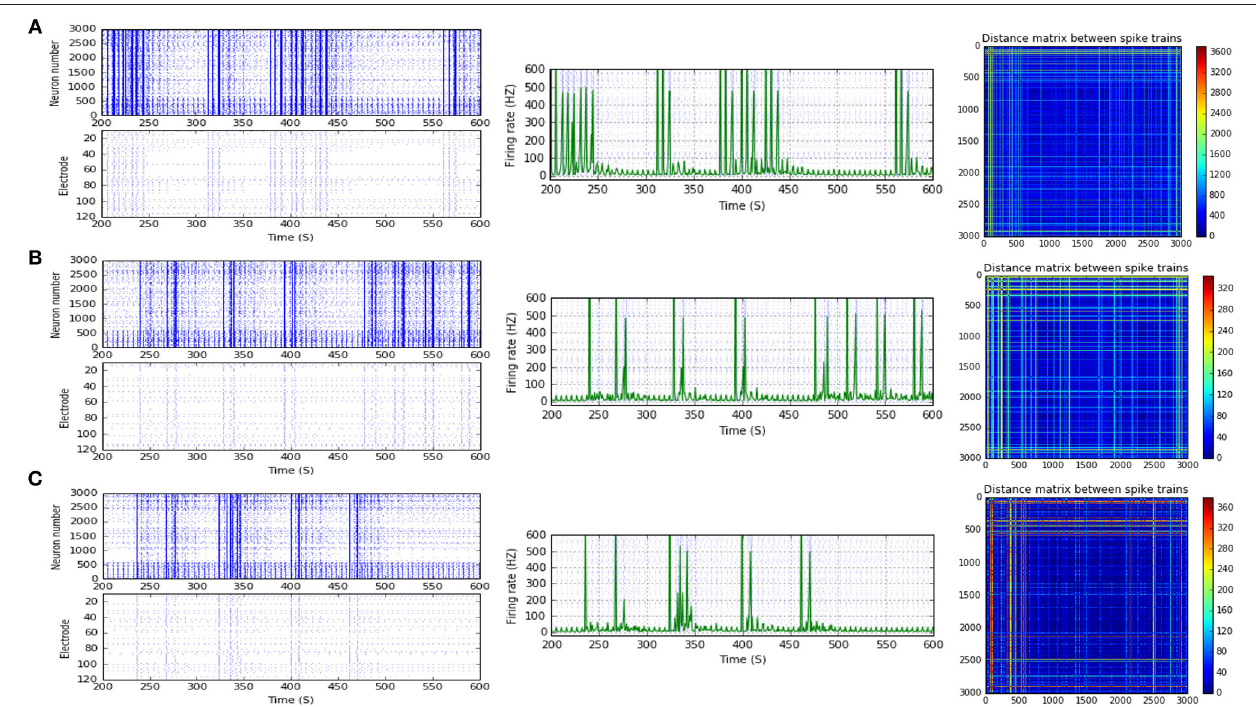
FIGURE 6 | Selected elicited firing response activity in the immature network scenario (B-2) before and after implementing STF1 and STF2 (when IF range of beta). (A) refers to the condition without implementing dynamical synapses (control) while (B,C) refer to that after implementing facilitating synapses (STF1 and STF2, respectively). The first two figures of each panel refer to monitoring the pattern of firing activity in time windows from 200 to 600 seconds(s). Heat maps of each panel represent modulation changes in spike distance matrix of the network scenario (B-2) before and after implementing STD1 and STF2. The simulation time for heat maps of the spike distance is equal to